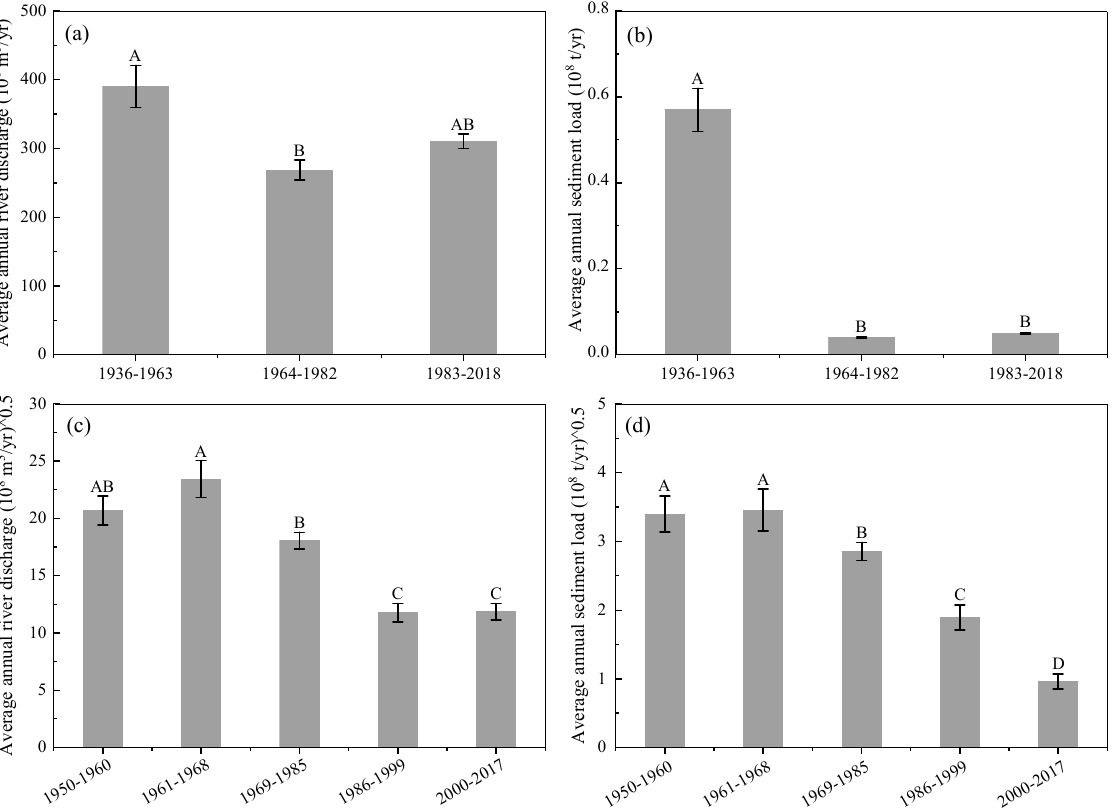
Figure 4. Comparison of ( a ) average annual river discharge and ( b ) sediment load of the Volta River Delta, and ( c ) average annual river discharge and ( d ) sediment load of the Yellow River Delta. Data are means ± SE. Differences for the Yellow River Delta and the Volta River Delta were tested by one-way ANOVA with LSD post-hoc multiple test and non-parametric Kruskal-Wallis test, respectively. Bars with different letters are significantly different ( p < 0.05).